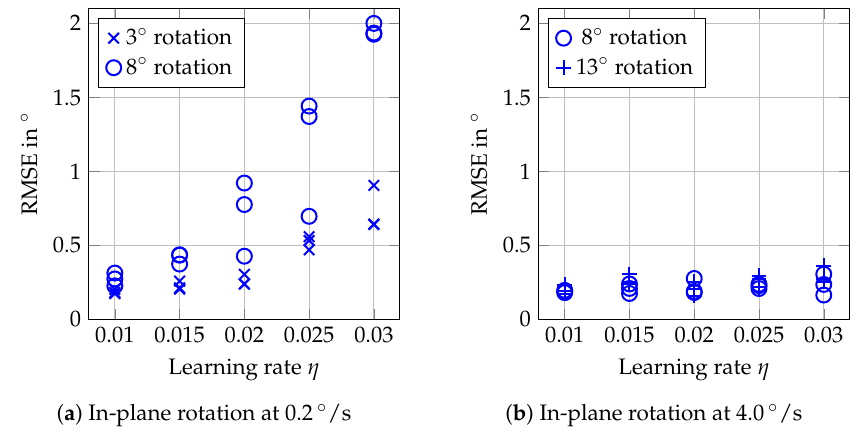
Figure 9. RMSEs for in-plane rotations with the different learning rates η from 0.01 to 0.03 of the MOSSE filter. Different maximum angles were used and the velocities were 0.2 ◦ /s ( a ) and 4 ◦ /s ( b ).